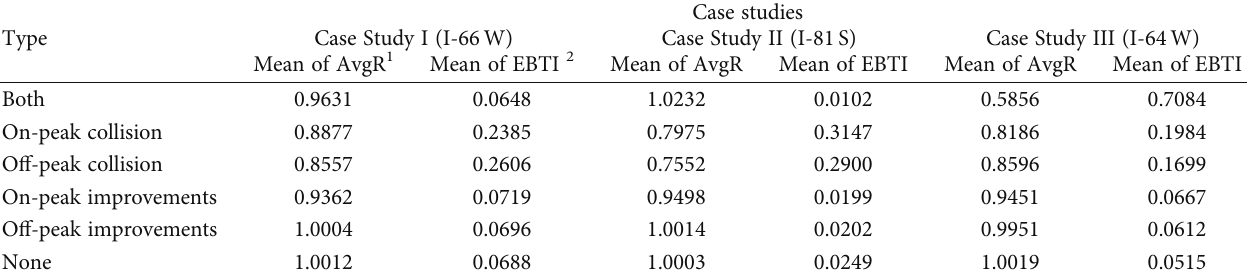
Figure 8: EBTI density plots. Table 9: Statics of AvgR and